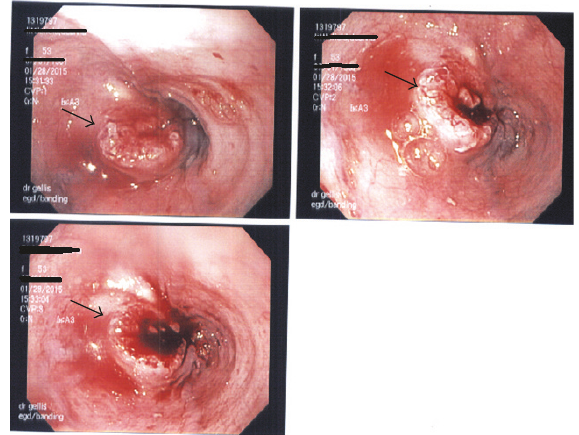
Figure 2: Images from an esophagogastroduodenoscopy showing a large obstructing mid-esophageal mass (arrows) at 25 cm.